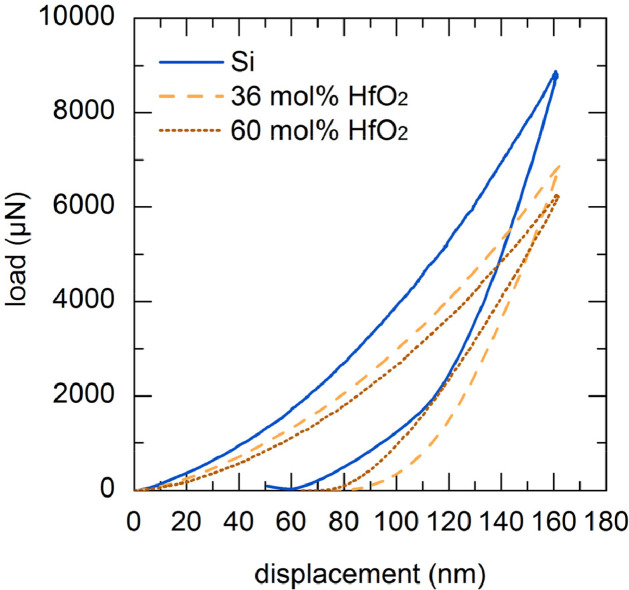
Comparison of the hysterses of silicon, 36 mol% HfO2-doped silicon and 60 mol% HfO2-doped silicon at 160 nm constant depth mode.